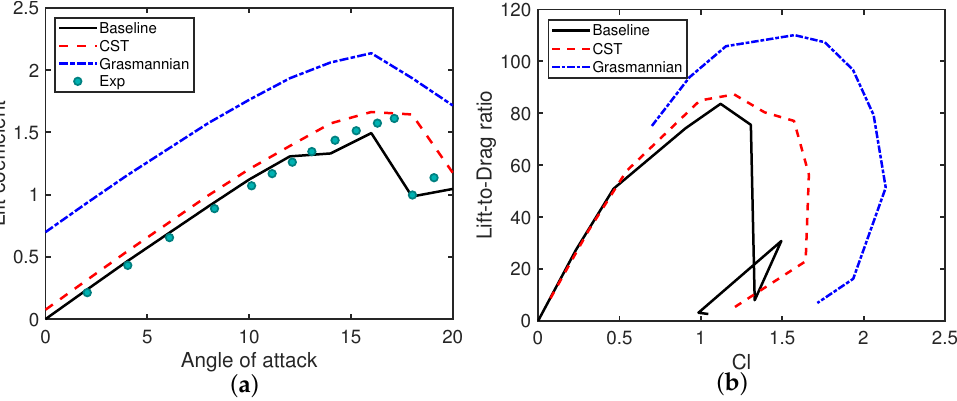
Figure 5. Aerodynamic performance of the optimized airfoils under subsonic conditions: ( a ) C l vs. α ; and ( b ) C l vs. K .